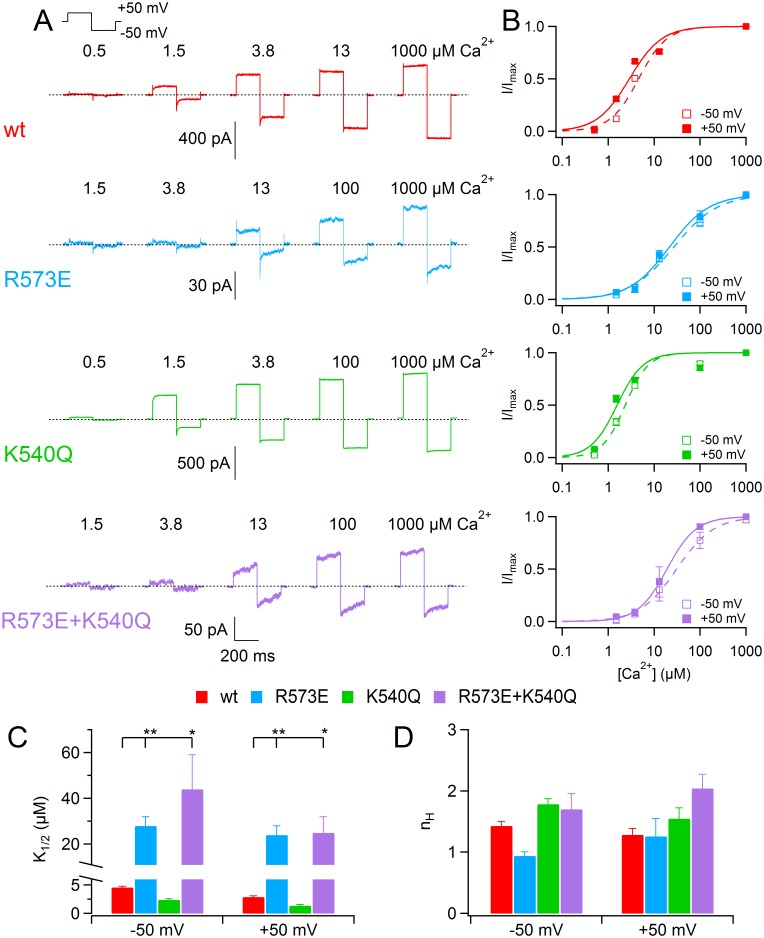
Ca2+ sensitivity of TMEM16B wt and mutant channels.(A) Each row shows current traces from the same inside-out patch expressing TMEM16A wt or the indicated mutants. The cytoplasmatic side was exposed to [Ca2+]i ranging from 0.5 to 1000 μM. Voltage steps of 200 ms duration were given from the holding voltage of 0 mV to +50 mV, followed by 200 ms step to -50 mV as indicated in the top part. Leakage currents measured in 0 Ca2+ were subtracted. (B) Dose-response relations of activation by Ca2+ were obtained by normalized currents at -50 and +50 mV and fitted with Hill equation (n = 6–7). (C) Mean of K1/2 at -50 and +50 mV for TMEM16B wt and mutant channels (*p<0.05 **p<0.01 Dunn test after Kruskal Wallis test). (D) Mean of nH at -50 and +50 mV for TMEM16B wt and mutant channels (p>0.05 Kruskal Wallis test).